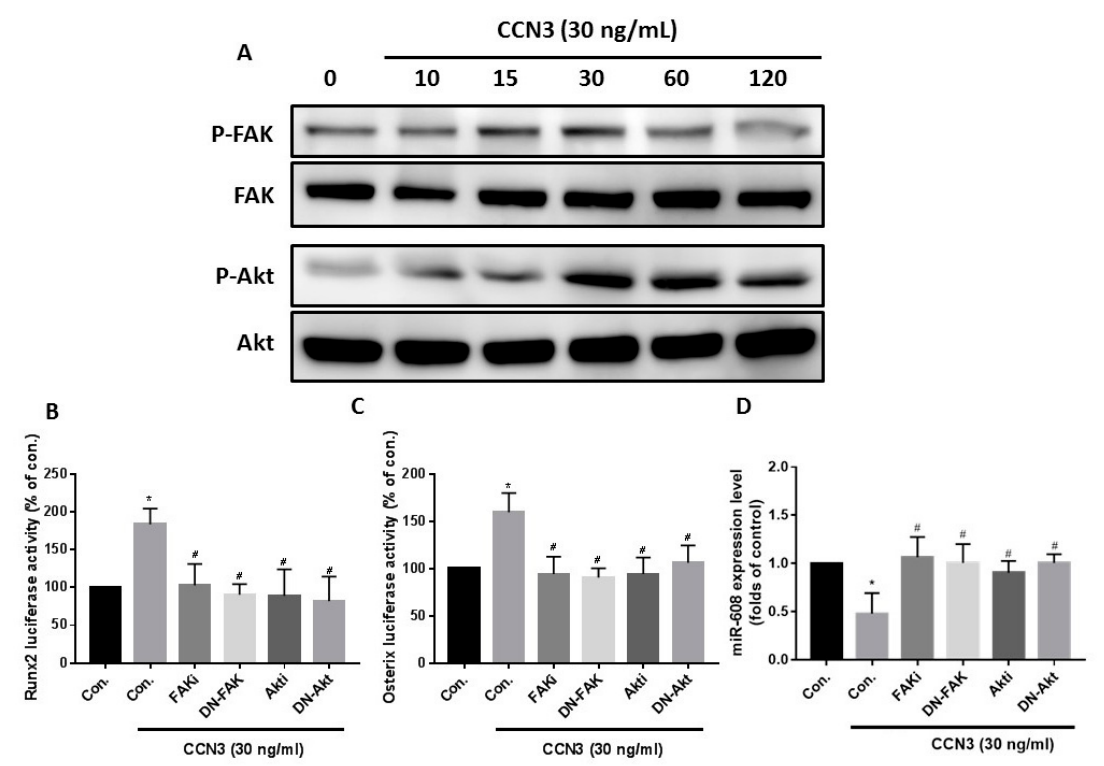
Figure 5. CCN3 suppressed miR-608 expression through the FAK and Akt signaling pathways. ( A ) Osteoblasts were treated with CCN3 (30 ng / mL) for the indicated time intervals; FAK and Akt phosphorylation were examined by Western blot assay. Osteoblasts were pretreated with FAK and Akt inhibitors or transfected with FAK and Akt mutants and subsequently stimulated with CCN3. Runx2 and osterix luciferase activity and miR-608 expression were examined by luciferase assay ( B , C ) and qPCR ( D ), respectively. Results are expressed as the mean ± S.E. * p < 0.05 as compared with the control group; # p < 0.05 as compared with the CCN3-treated group.